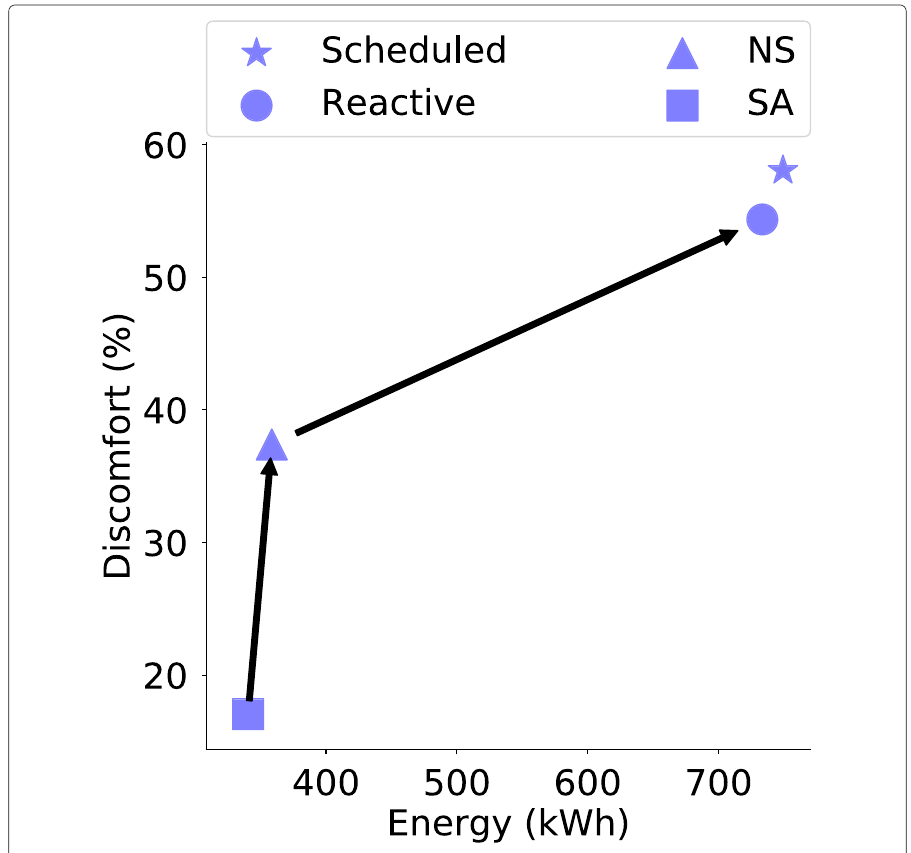
Fig. 9 Winters. Energy-discomfort plot when prediction is perfect. The arrow indicates the performance degradation, in terms of energy consumption and user comfort, when we move from predictive to non-predictive control strategies